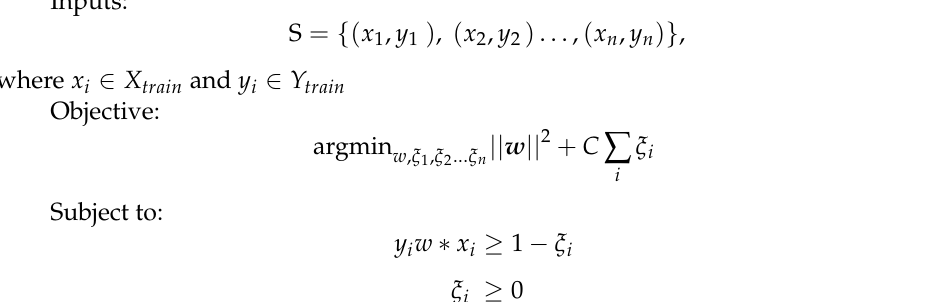
Figure 6. The personal comfort model pipeline in the first phase.